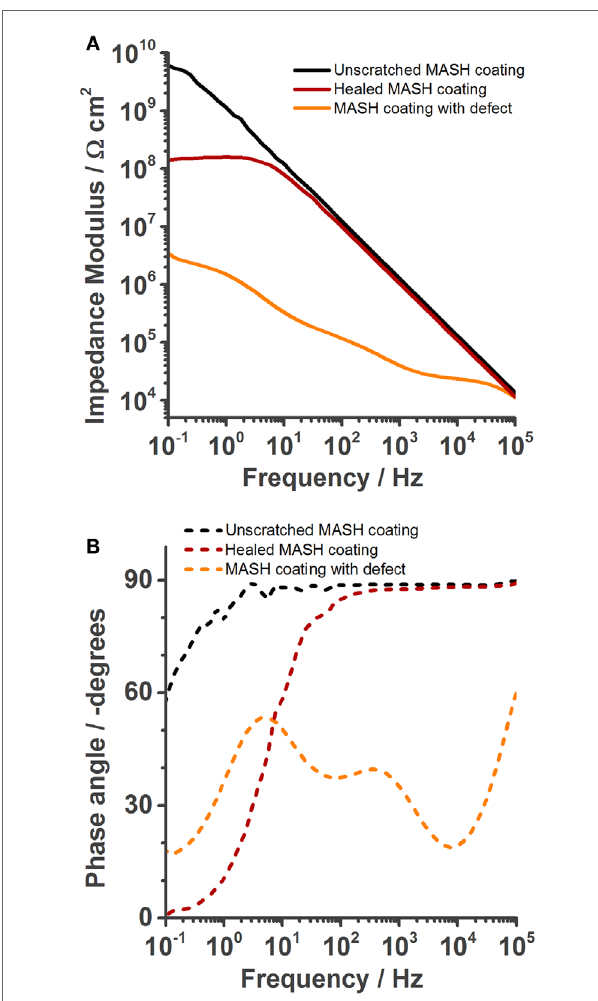
FigUre 10 | electrochemical impedance spectroscopy spectra recorded in 0.05 M nacl solution after OcP was constant (about 5 min), showing the increase of barrier properties achieved by healing of the self-healing polymer at 60°c for 2 min . (a) Bode modulus, (B) bode phase plot.